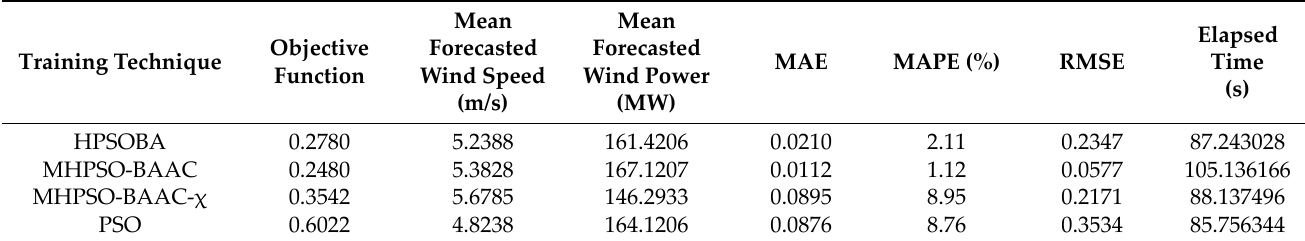
Table 3. Values of the mean forecasted wind speed, power, and accuracy‑Testing parameter through the